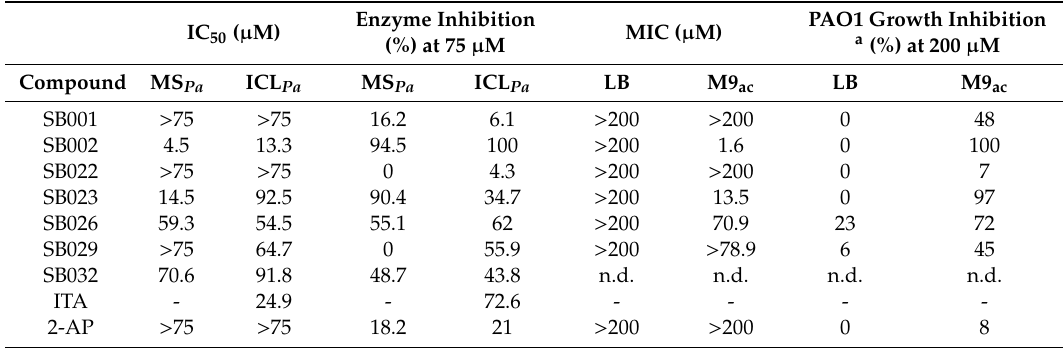
Table 1. IC 50 and MIC values for the 2-aminopyridine inhibitors of the glyoxylate shunt enzymes and P. aeruginosa PAO1 growth